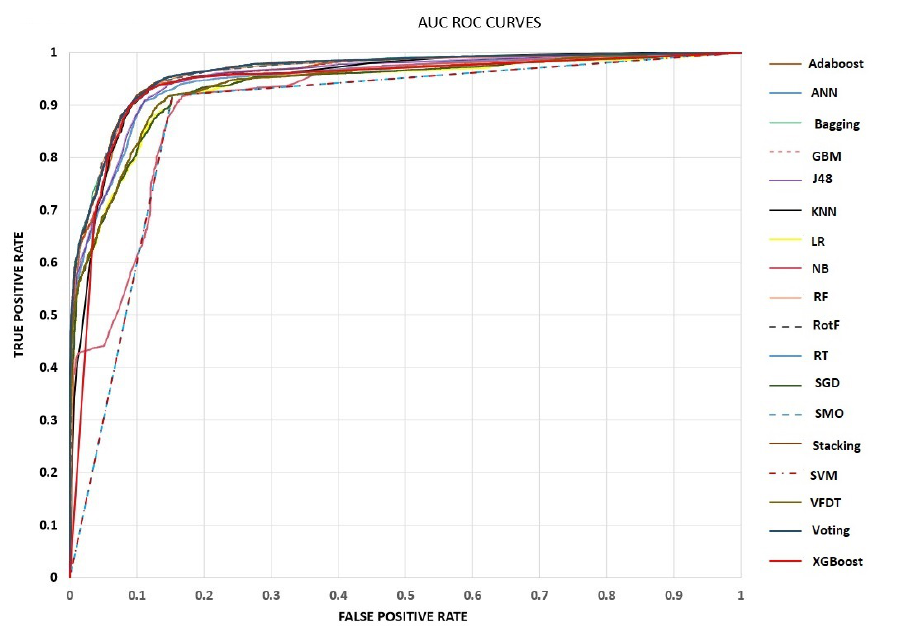
Figure 2. AUC ROC